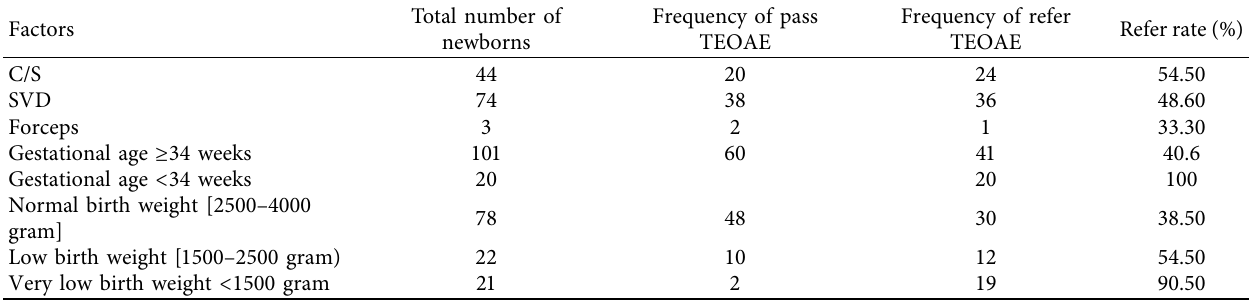
Table 3: The refer rate of follow-up screening of TEOAE according to the mode of delivery, gestational age, and birth weight (6). Factors